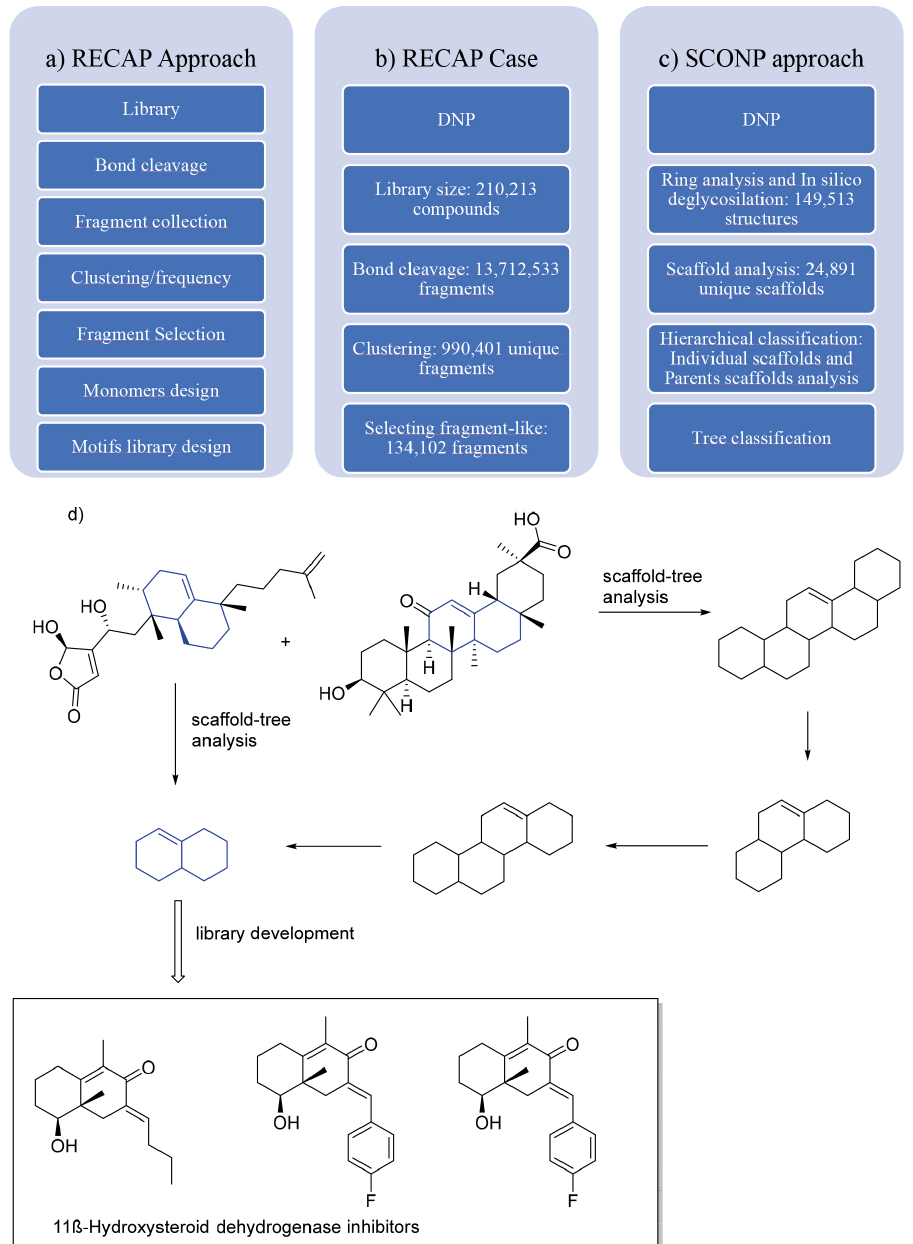
FIGURE 9 - Virtual fragmentation by RECAP and SCONP approach (a and c); RECAP construction of a fragment library (b); and SCONP approach toward bioactive compound development